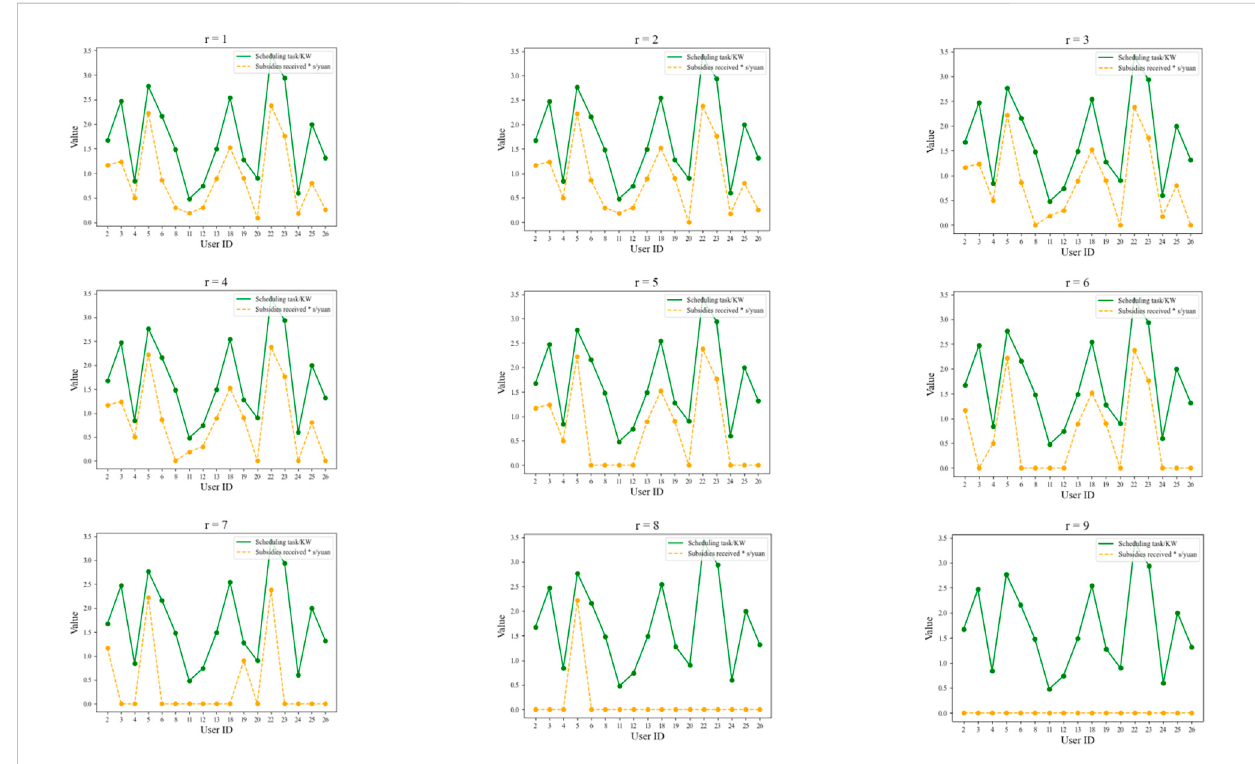
FIGURE 9 Differences of subsidies obtained by users under different reputation thresholds ( r ∈ [ 1 , 9 ]